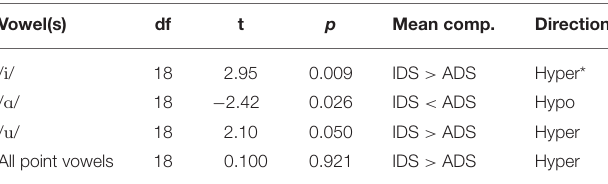
Bonferroni-corrected alpha is 0.013. Column headings as in Table 5